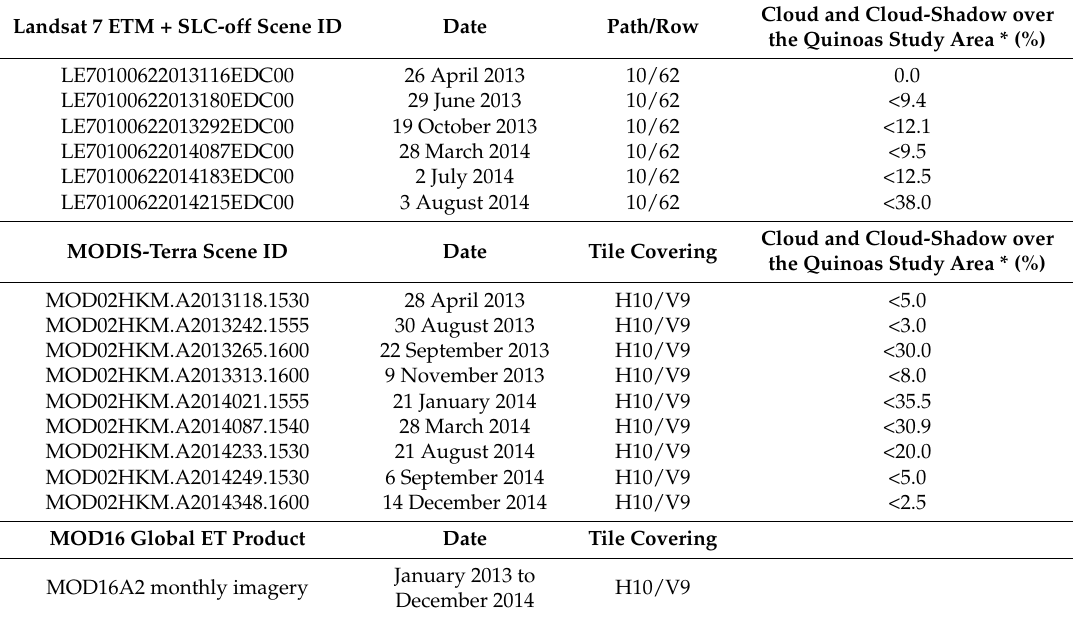
Table 3. Landsat and MODIS imagery for the study